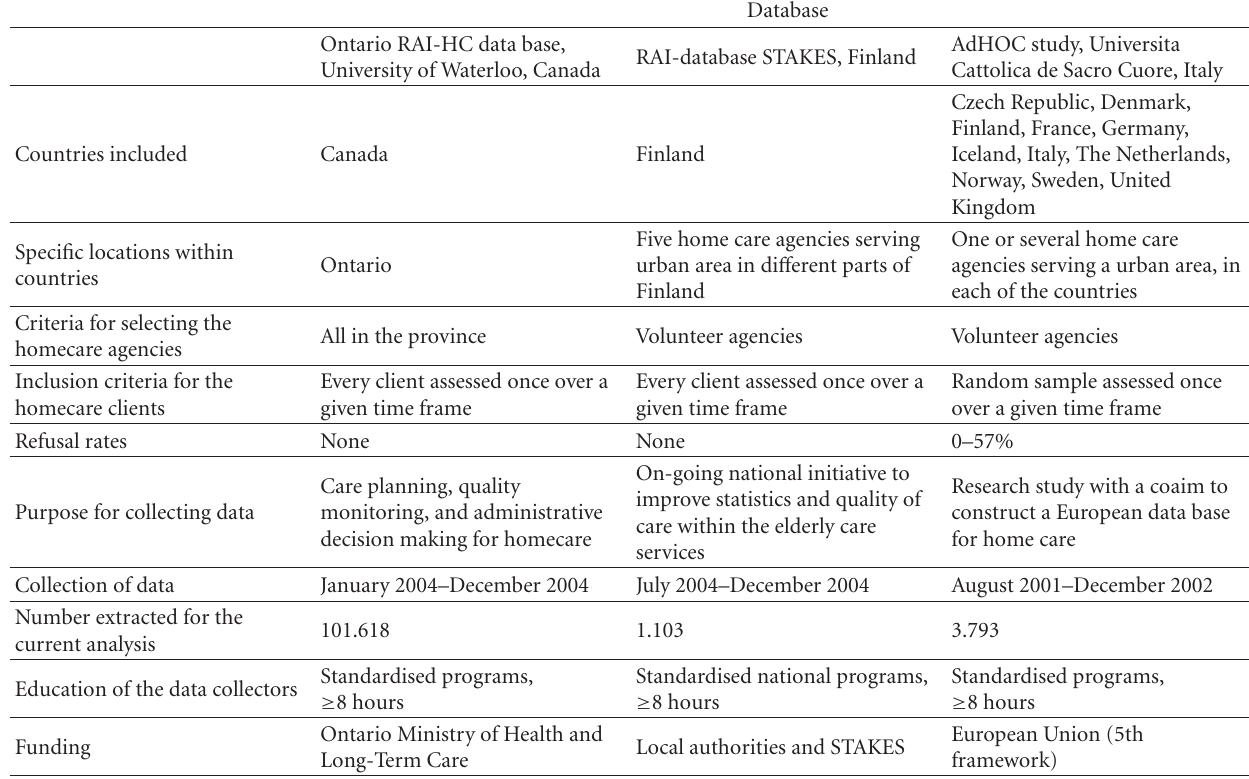
Table 1: Comparison of the three